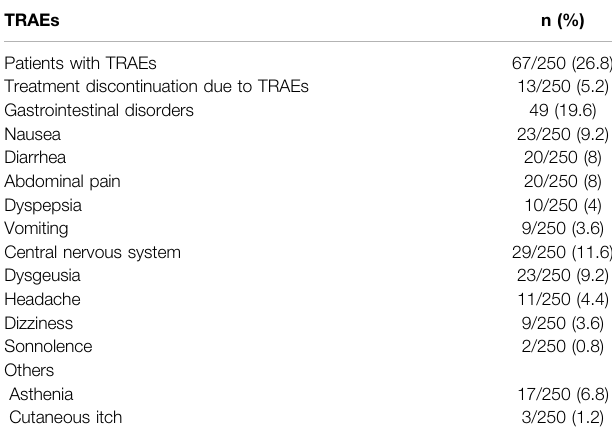
TABLE 2 | Treatment-related adverse events